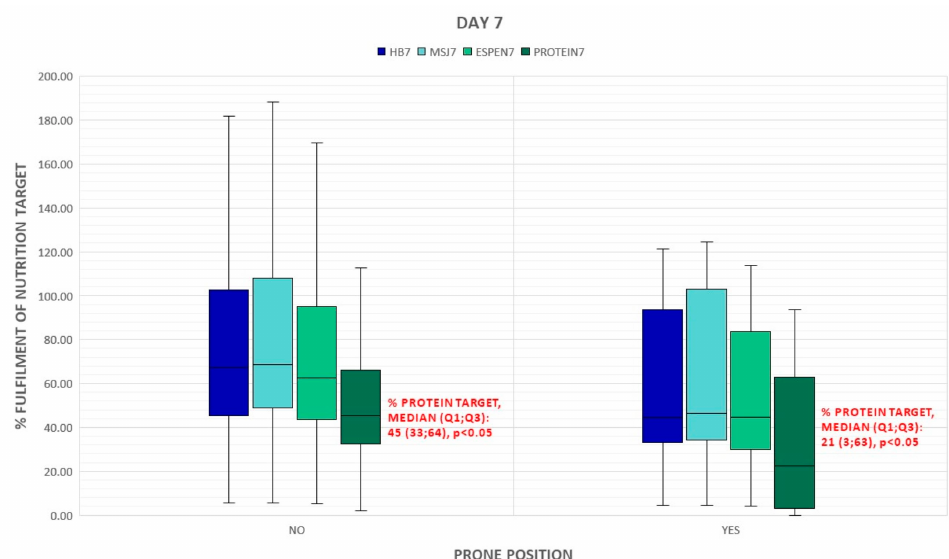
Figure 4. Prone positioning during ICU stay and delivery of energy and proteins on day 7. BH: Harris–Benedict equation; MsJ: Mifflin–St, Jeor equation; OX: passive oxygen therapy; NIV: non-invasive ventilation; IMV: invasive mechanical ventilation.